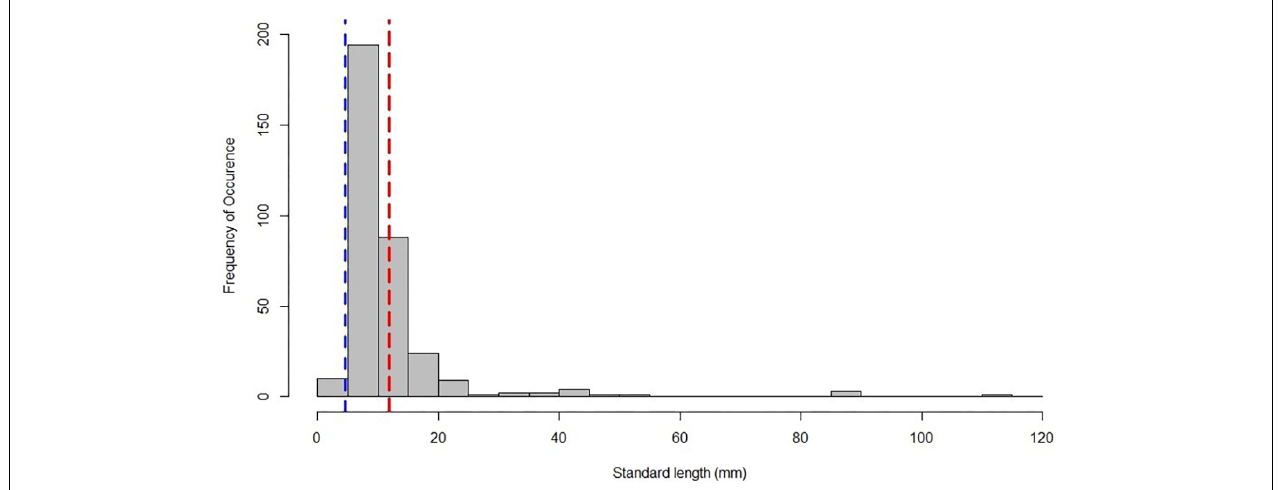
FIGURE 1 | Size-frequency plot of larval and juvenile scombrids collected from January to September in 2011, with the average-sized specimen indicated by the red dashed line. The blue dashed line signifies the average-sized specimen collected on DEEPEND’s complementary ichthyoplankton cruises (4.6 mm SL; Cornic et al.,